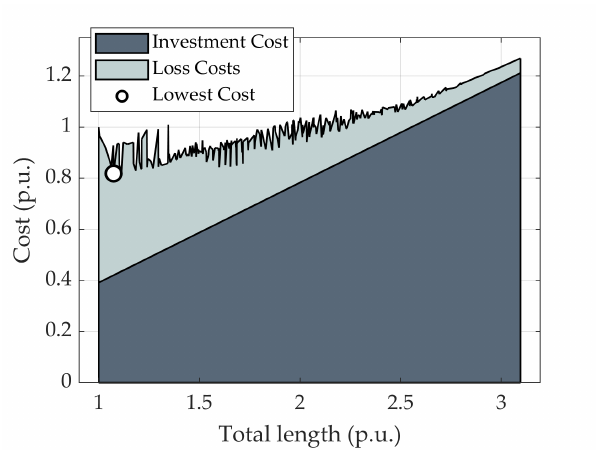
Figure 4. Total cost split of the